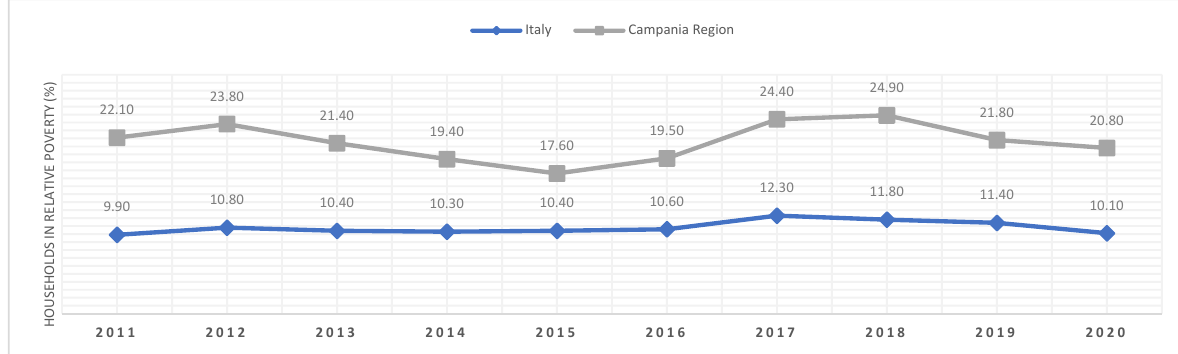
Figure 1. Incidence of household-relative poverty. Source: Authors’ elaboration from ISTAT (data extracted on 25 May 2022 12:05 UTC